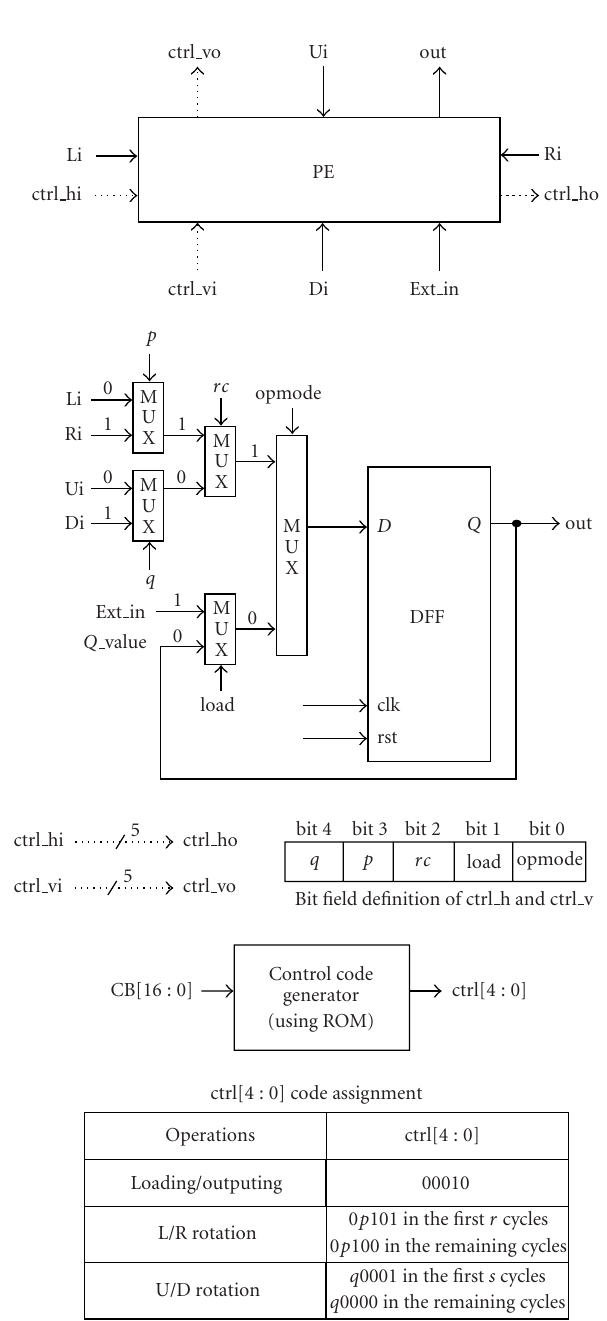
Figure 6: The architecture of the PEs used in the DSB in the proposed